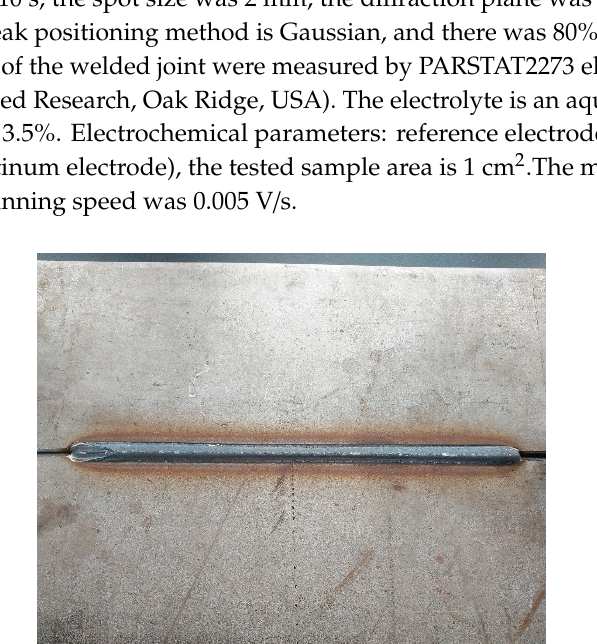
Figure 1. View of T4003 stainless steel welded joint.